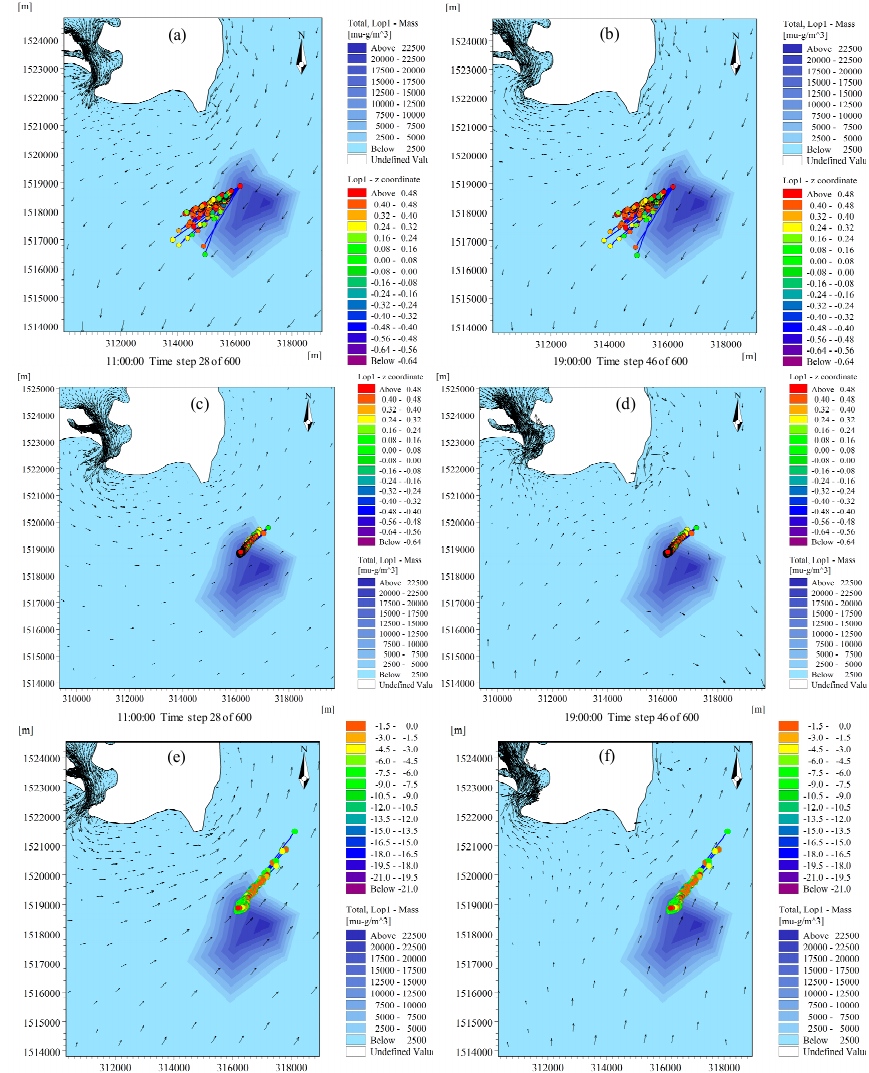
Figure 11. The simulation results of transferring sedimentation position in low tide and high tide in S1 ( a , b ); S2 ( c , d ); S3 ( e , f ).